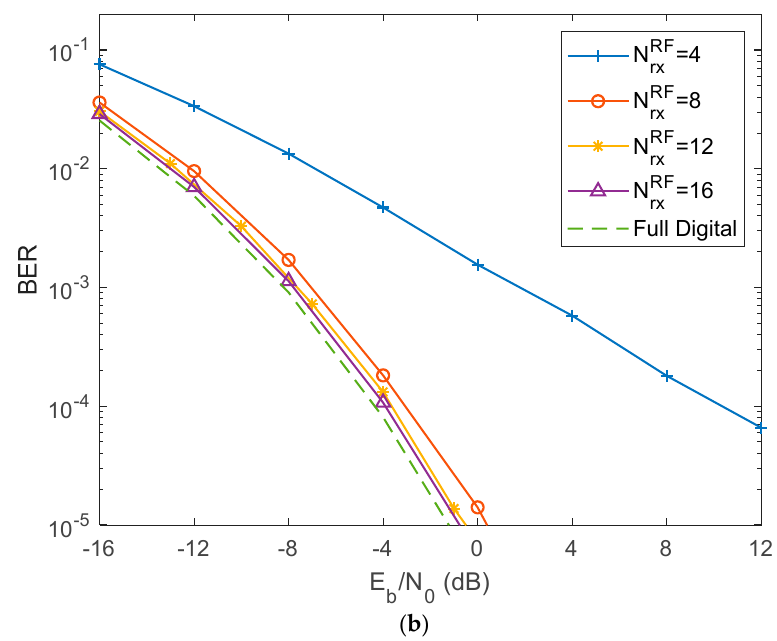
Figure 5. Performance comparison of the proposed hybrid precoders with the full digital system for N tx = 16, and N rx = 64: ( a ) random-based precoder, ( b ) AoD-based precoder.